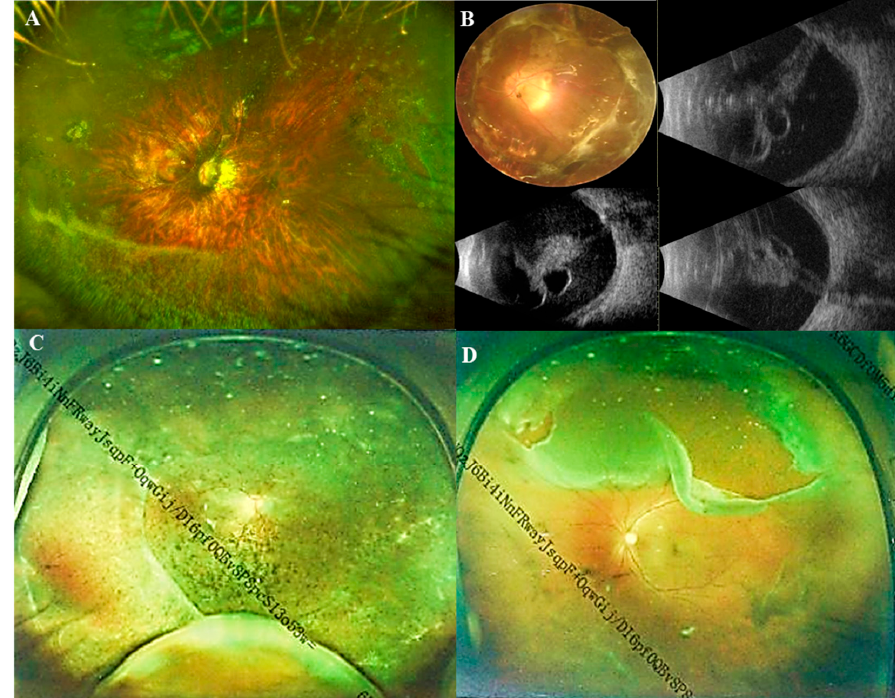
Figure 3. Ultra-wide-angle fundus images and B-scan ultrasonography images of Marfan patients. ( A ) Ultra-wide-angle fundus image of a pathological myopic eye with nasal retinal breaks and a horseshoe tear in superotemporal; ( B ) A fundus image and B-scan ultrasonography images of a pathological myopic eye with a total retinal detachment; ( C ) Ultra-wide-angle fundus image of a pathological myopic eye with retinal detachment in superotemporal, inferotemporal, and inferonasal quadrants; ( D ) Ultra-wide-angle fundus image of a pathological myopic eye with a giant retinal tear above. Table 4. Characteristics and Comparison among Pathological Myopic Eyes with Three Different Maculopathy